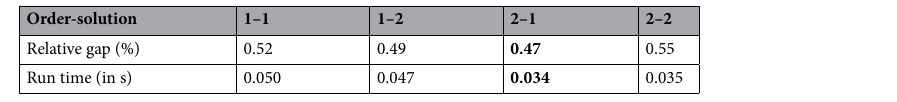
Table 3. Performance of different operator orders and initial solutions ( J = 20 , α = 0.90 ). Significant values are in